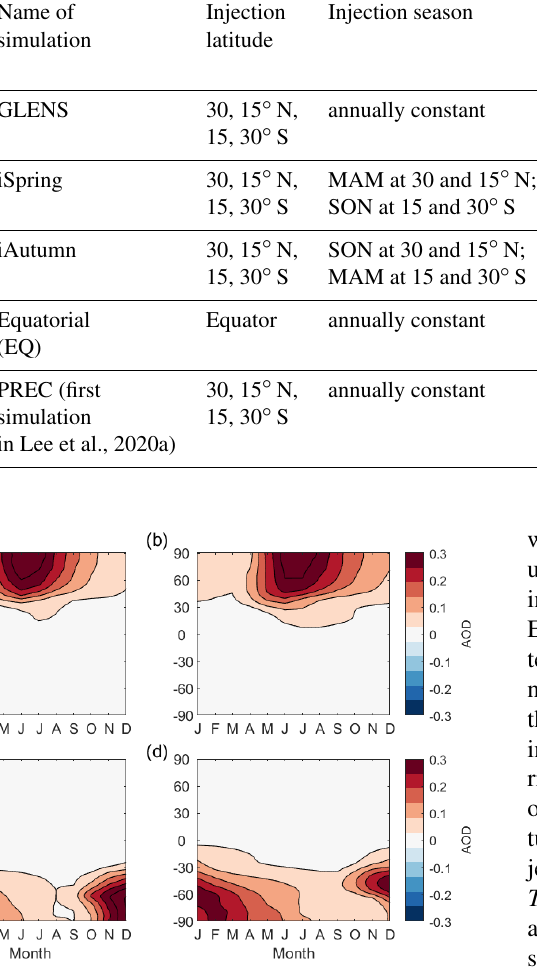
Figure 2. Spatiotemporal AOD patterns of spring injections at (a) 60 ◦ N, (b) 45 ◦ N, (c) 60 ◦ S, and (d) 45 ◦ S. The AOD patterns of spring injections in the same hemisphere are similar to each other, while the injections in the opposite hemispheres produce very dif- ferent AOD